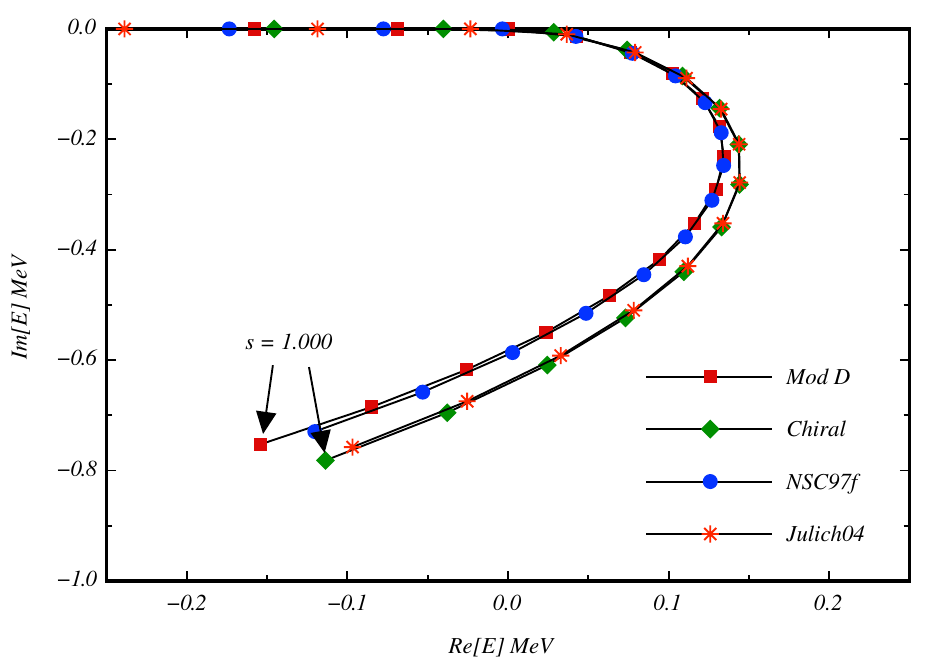
Figure 2: Trajectories of the Λ nn pole as one scales the Λ n Yamaguchi potentials with effective range parameters equivalent to two Nijmegen (Mod D , NSC 97 f ) and two Jülich (Jülich04, Chiral)